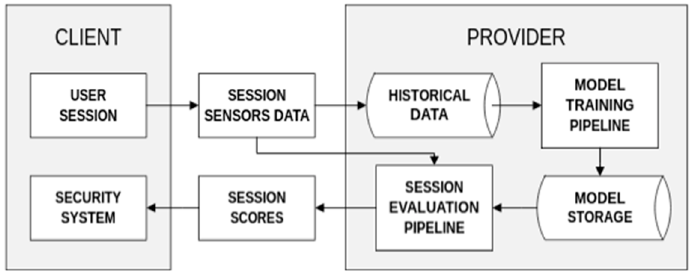
Figure 1. Data exchange pipeline for the behavioral biometry security system.